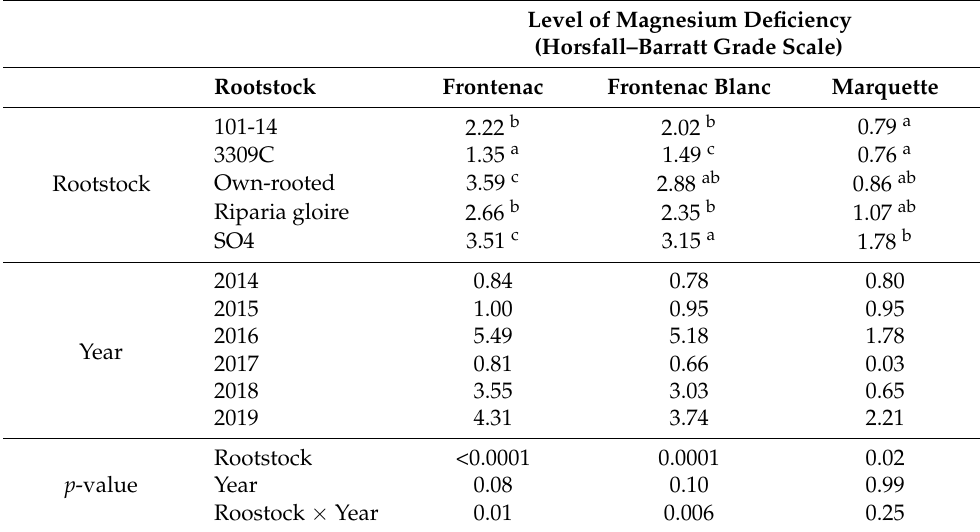
Table 6. Effect of rootstock on nutrient deficiencies of the three cold hardy